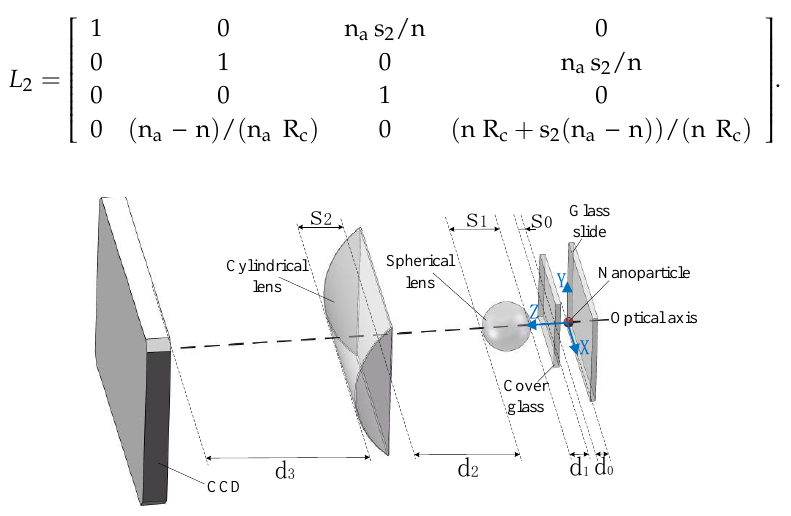
Figure 1. Optical Figure 1. Optical configuration.